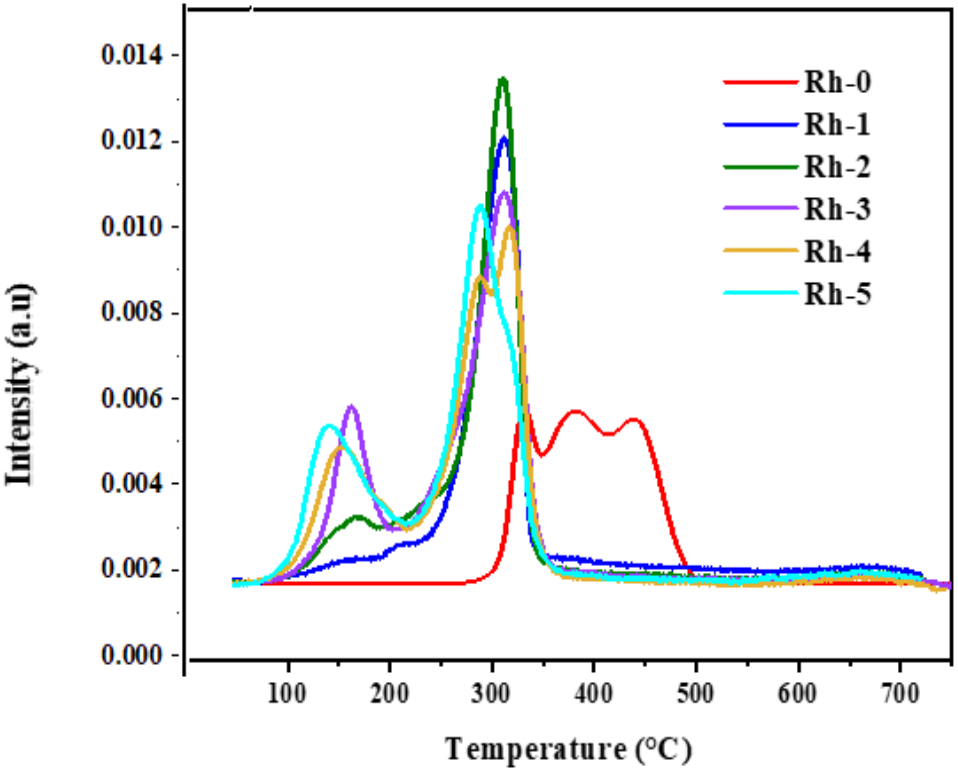
Figure 3. H 2 -TPR profiles of fresh Rh-x (x = 0, 1, 2, 3, 4, and 5 wt.%) catalysts. Table 2. H 2 consumption for promoted and unpromoted Rh 2 O 3 catalysts.